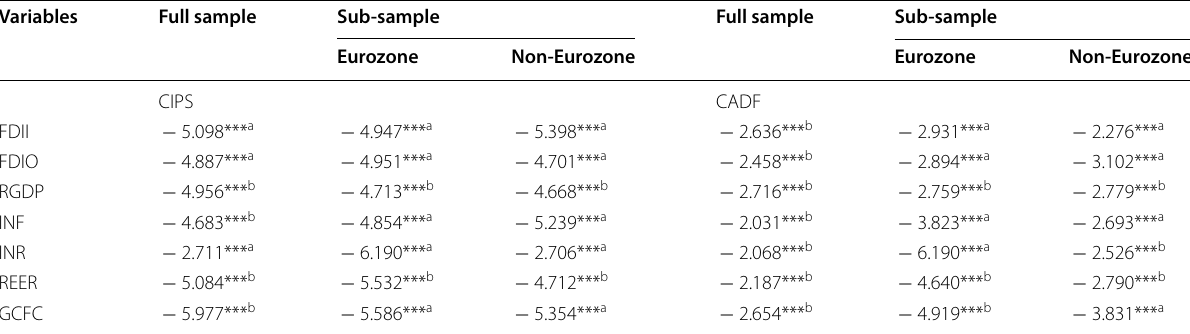
Table 3 Unit root test